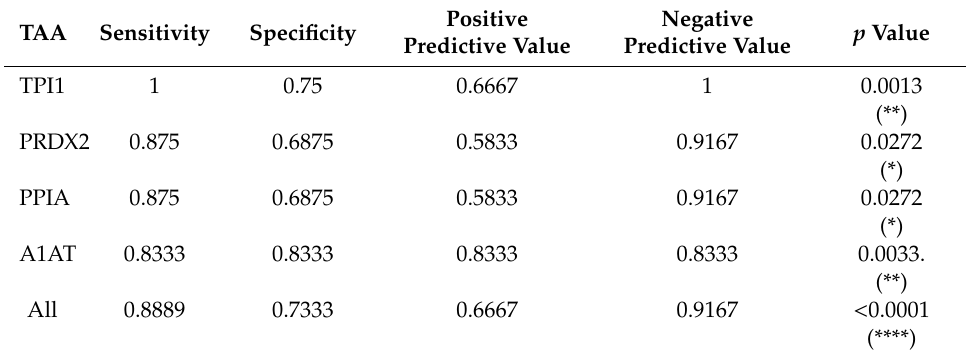
Table 3. Results by statistical analysis using chi-square and Fisher exact test, with a 95% confidence interval, from the results of immunoreactivity. In addition to p-value, asterisks describe values levels of statistical significance. Since significant (*) to extreme significance